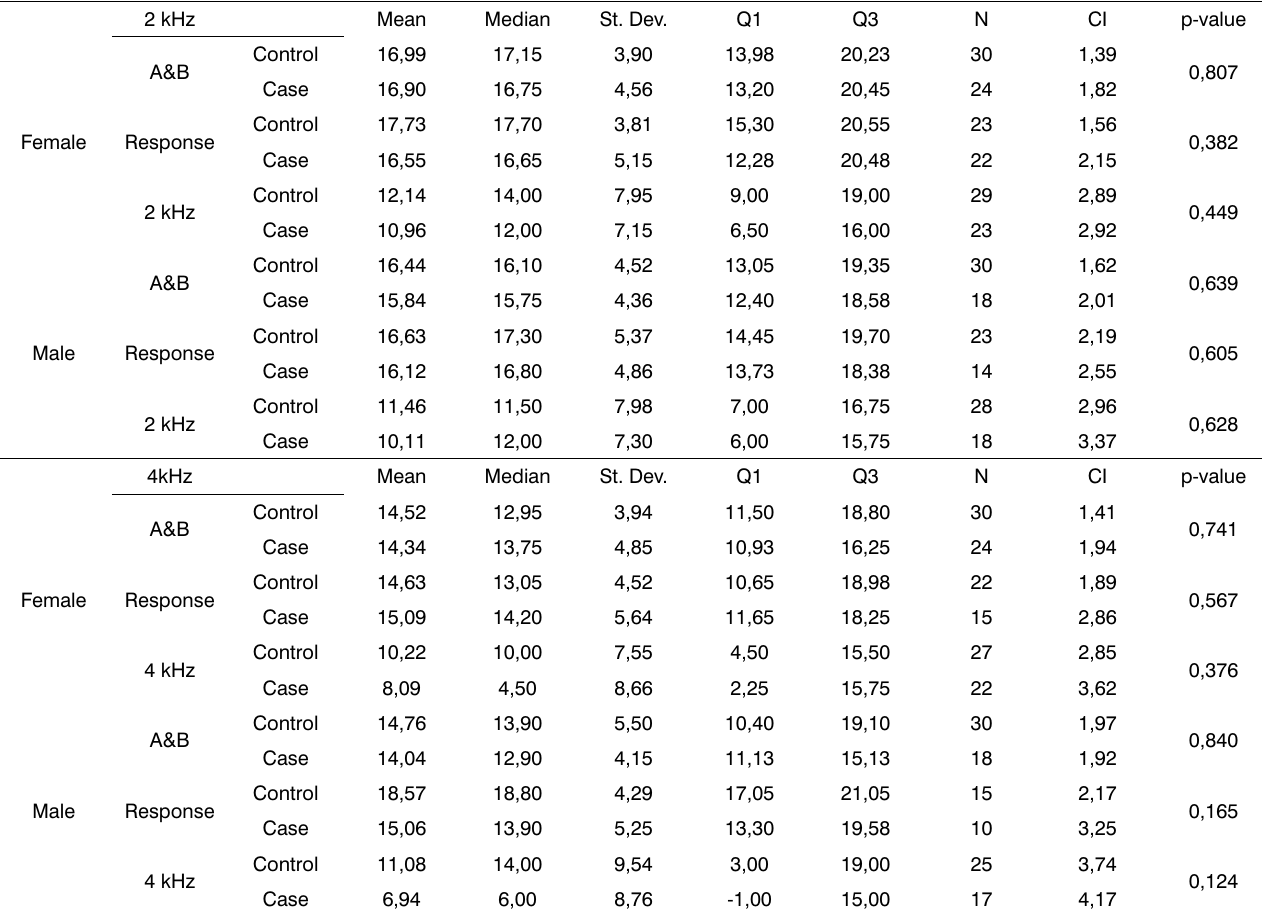
Table 4. Response magnitude (dB), descriptive analysis and comparison (p-value) between control and case groups, for TB 2 kHz and TB 4 kHz 2 kHz